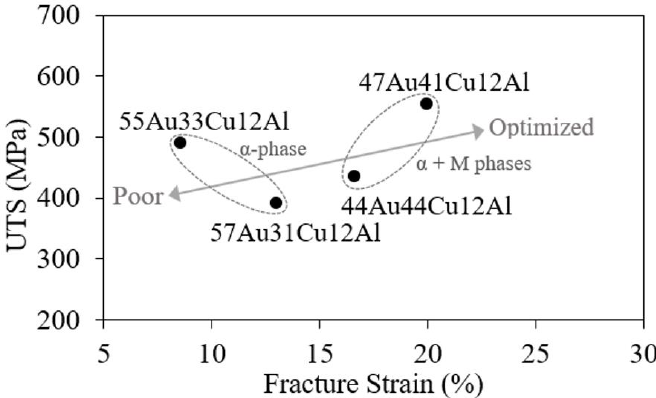
Figure 5. The relationship between the UTS and the fraction strain of 57Au31Cu12Al, 55Au33Cu12Al, 47Au41Cu12Al, and 44Au44Cu12Al alloys. (The α and M indicate the α-phase and the DB19 martensite phase, respectively).